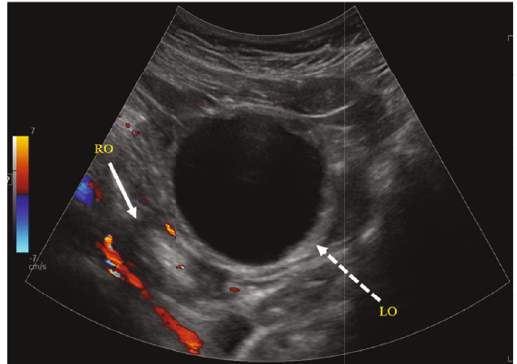
Figure 3: Transabdominal sagittal view of the pelvis with color Doppler, inferior to the uterus, demonstrates the right ovary (solid white arrow) with normal vascular fl ow. However, the left ovary (dashed white arrow), displaced by a large anechoic simple cyst, does not demonstrate vascular fl ow.